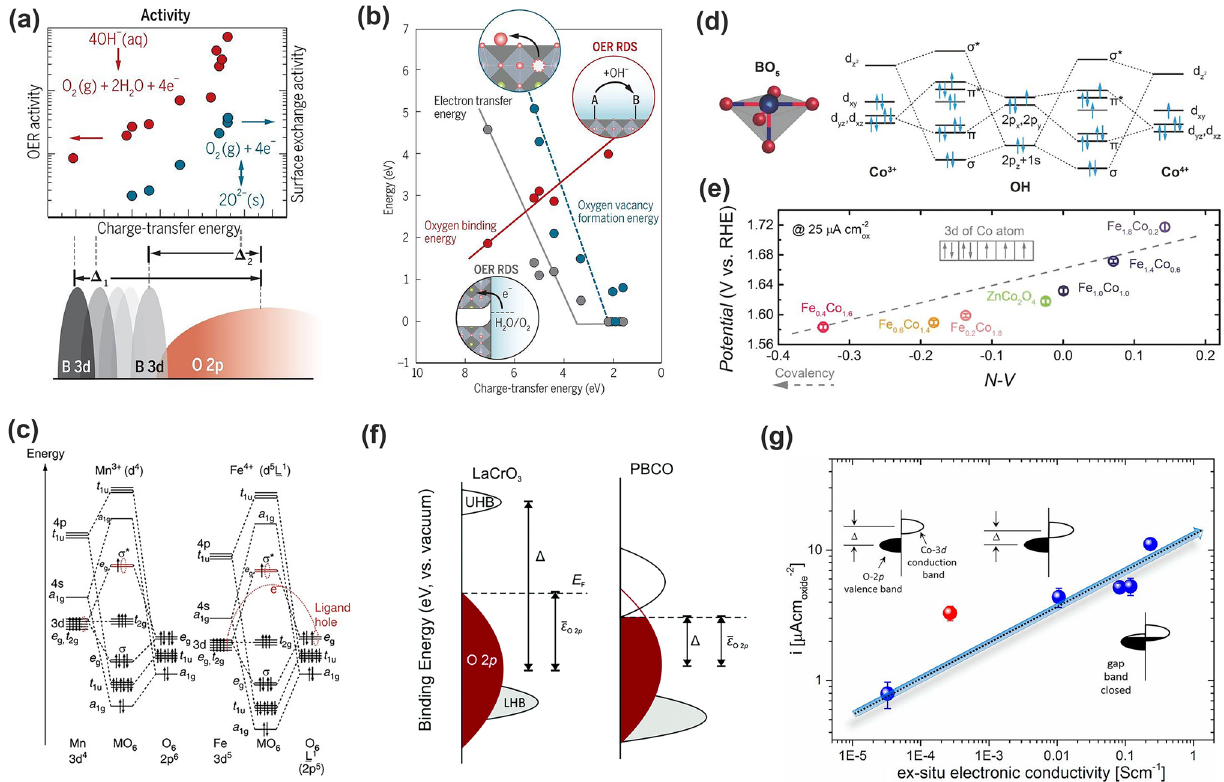
Fig. 7 Correlation between Metal–oxygen covalency and OER activities. a Correlations between charge-transfer energy and OER activity (red), surface exchange activity (blue), and the OER active site identity in the 3d transition metals. b Relationship of charge-transfer energy to relevant energetics and rate-determining steps: oxygen vacancy formation (blue), oxygen binding energy (red), and electron transfer energy (gray) [78]. Copyright © 2017 American Association for the Advancement of Science. c Schematic illustration of molecular orbitals for regular Mn 3+ O 6 and Fe 4+ O6 octahedra. The Mn 3+ and Fe 4+ ion 3 d -orbital energy levels are higher and lower than those of the O 2 p orbitals, respectively [83]. Copy- right © 2015 Springer Nature. d Molecular orbital diagrams of Co–OH (Co 3+ and Co 4+ ) bonding at the surface of spinel oxides. e OER activity as a function of the N–V parameter [84]. Copyright © 2018 Wiley–VCH. f Scheme for the charge-transfer energy: the relative energies of TM 3d and O 2p valence electronic states [79]. Copyright © 2017 Royal Society of Chemistry. g Current density (μA cm oxide−2 ) as a function of the ex situ electronic conductivity of the La 1− x Sr x CoO 3 series; the red circle represents the SrCoO 2.5 [88]. Copyright © 2015 American Chemical Society. (Color figure